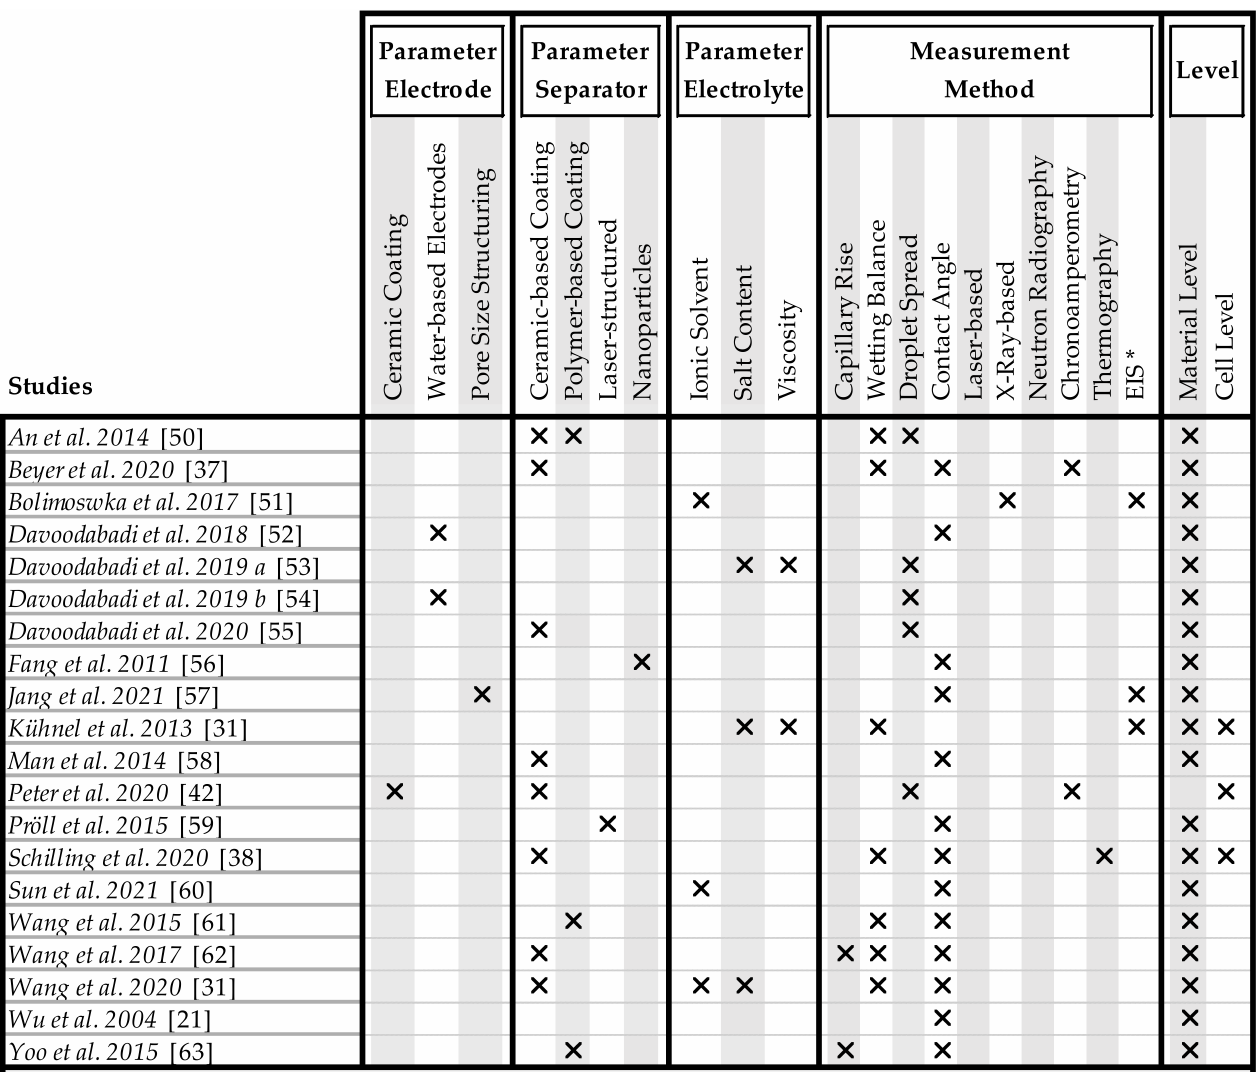
Table 1. Overview of the publications assigned to the category material with a classification of